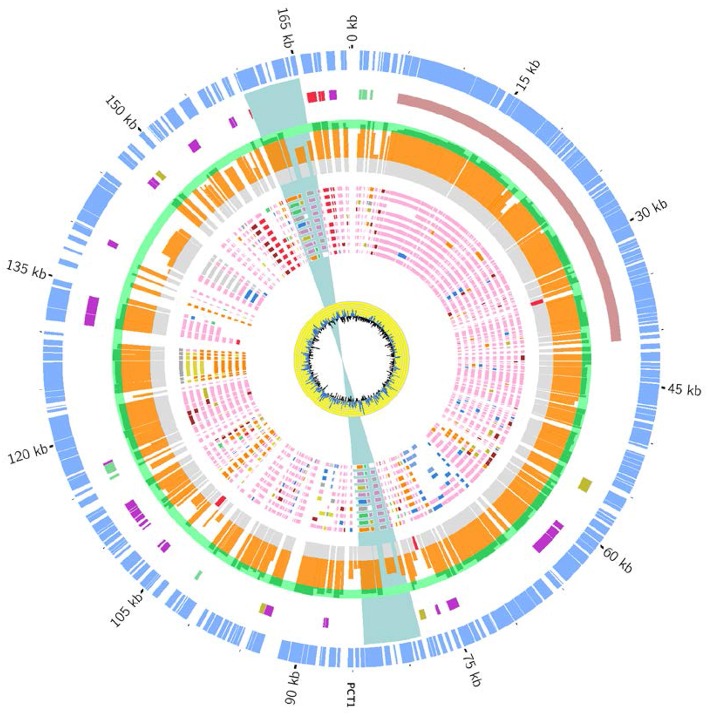
Overview and organization of the pCitro1 plasmid. From outside to inside circles. The light blue tiles are the pCitro1 ORFs. The violet tiles are Transposases/Resolvases; the ORFs related to the Y. pestis pPCP1 are in red; the tra operon is in dark blue and the blue ribbon indicates a 5 kb inverted repeat. The protein sequence identity with its best blast hit is plotted in the continuous gray (twilight zone <25%), orange (25–90%), and light green (>90%) circles. Below, ten circles showing the taxonomic origin of the ten best blast hits of each protein. Pink, orange, blue and red tiles belong to Escherichia, Citrobacter, Klebsiella and Yersinia genera, respectively. The yellow circle plot is the GC skew.